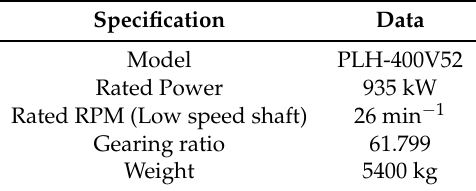
Figure 2. Metso PLH-400V52 gearbox. Table 1. Gearbox -principal